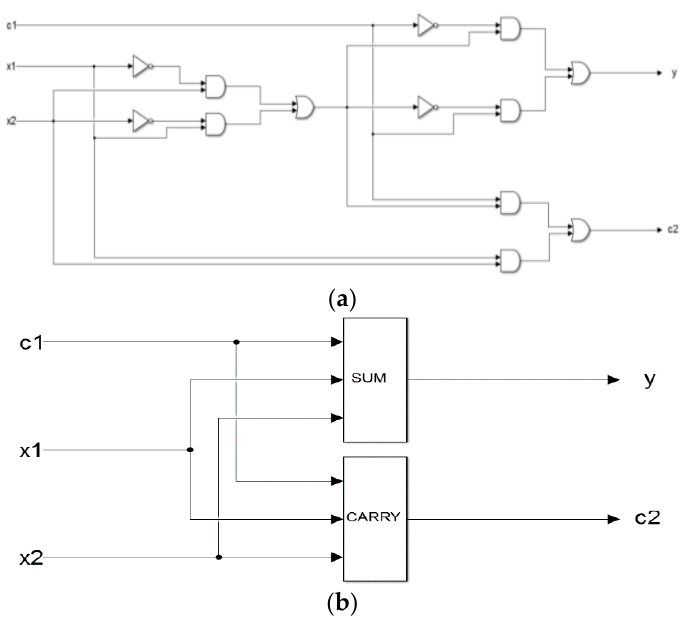
Figure 11. ( a ). Single-rail one-bit full adder; ( b ). One-bit full adder with a domain